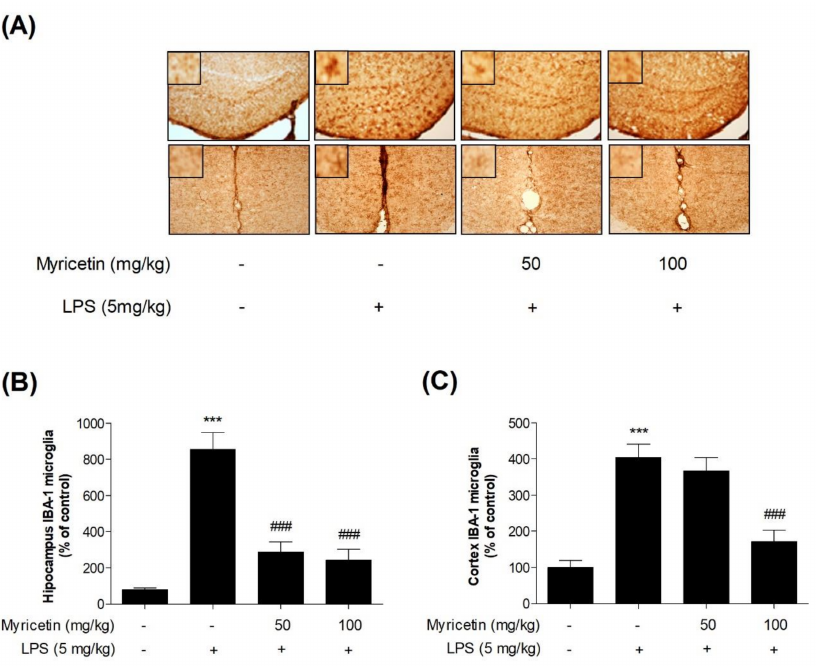
Figure 6. The e ff ect of myricetin on LPS-induced microglial activation in the hippocampus and cortex in mice. Following myricetin administration and LPS treatment in mice, microglia activation was measured by IHC. ( a , b ) The number of activated microglia in the hippocampus and ( a , c ) cortex were measured. Scale bars = 250 µ m. Values are presented as means ± standard error of the mean. * p < 0.05 and ** p < 0.01 compared with the control group, # p < 0.05, ## p < 0.01, and ### p < 0.001 compared with the LPS-treated group. LPS, lipopolysaccharide; IHC,